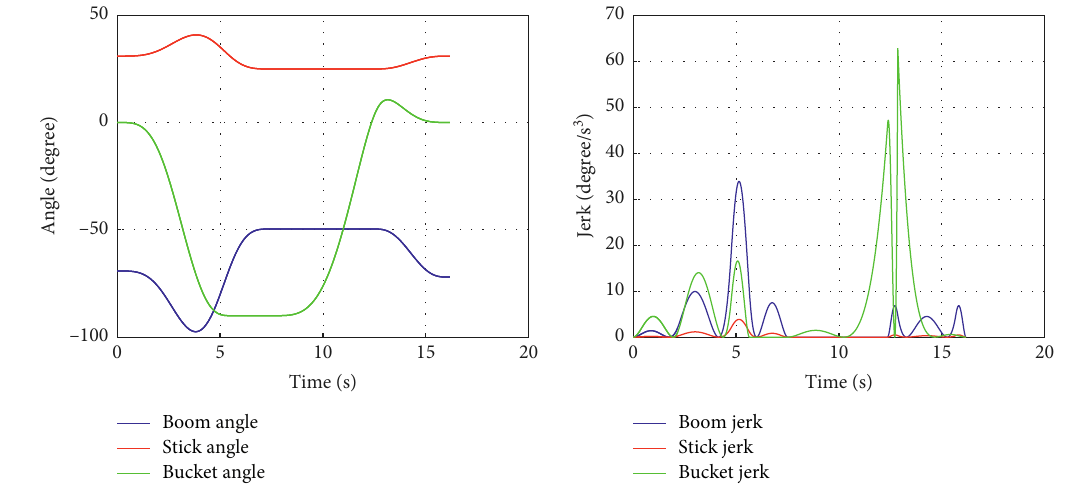
Figure 7: Joint angle and jerk with k